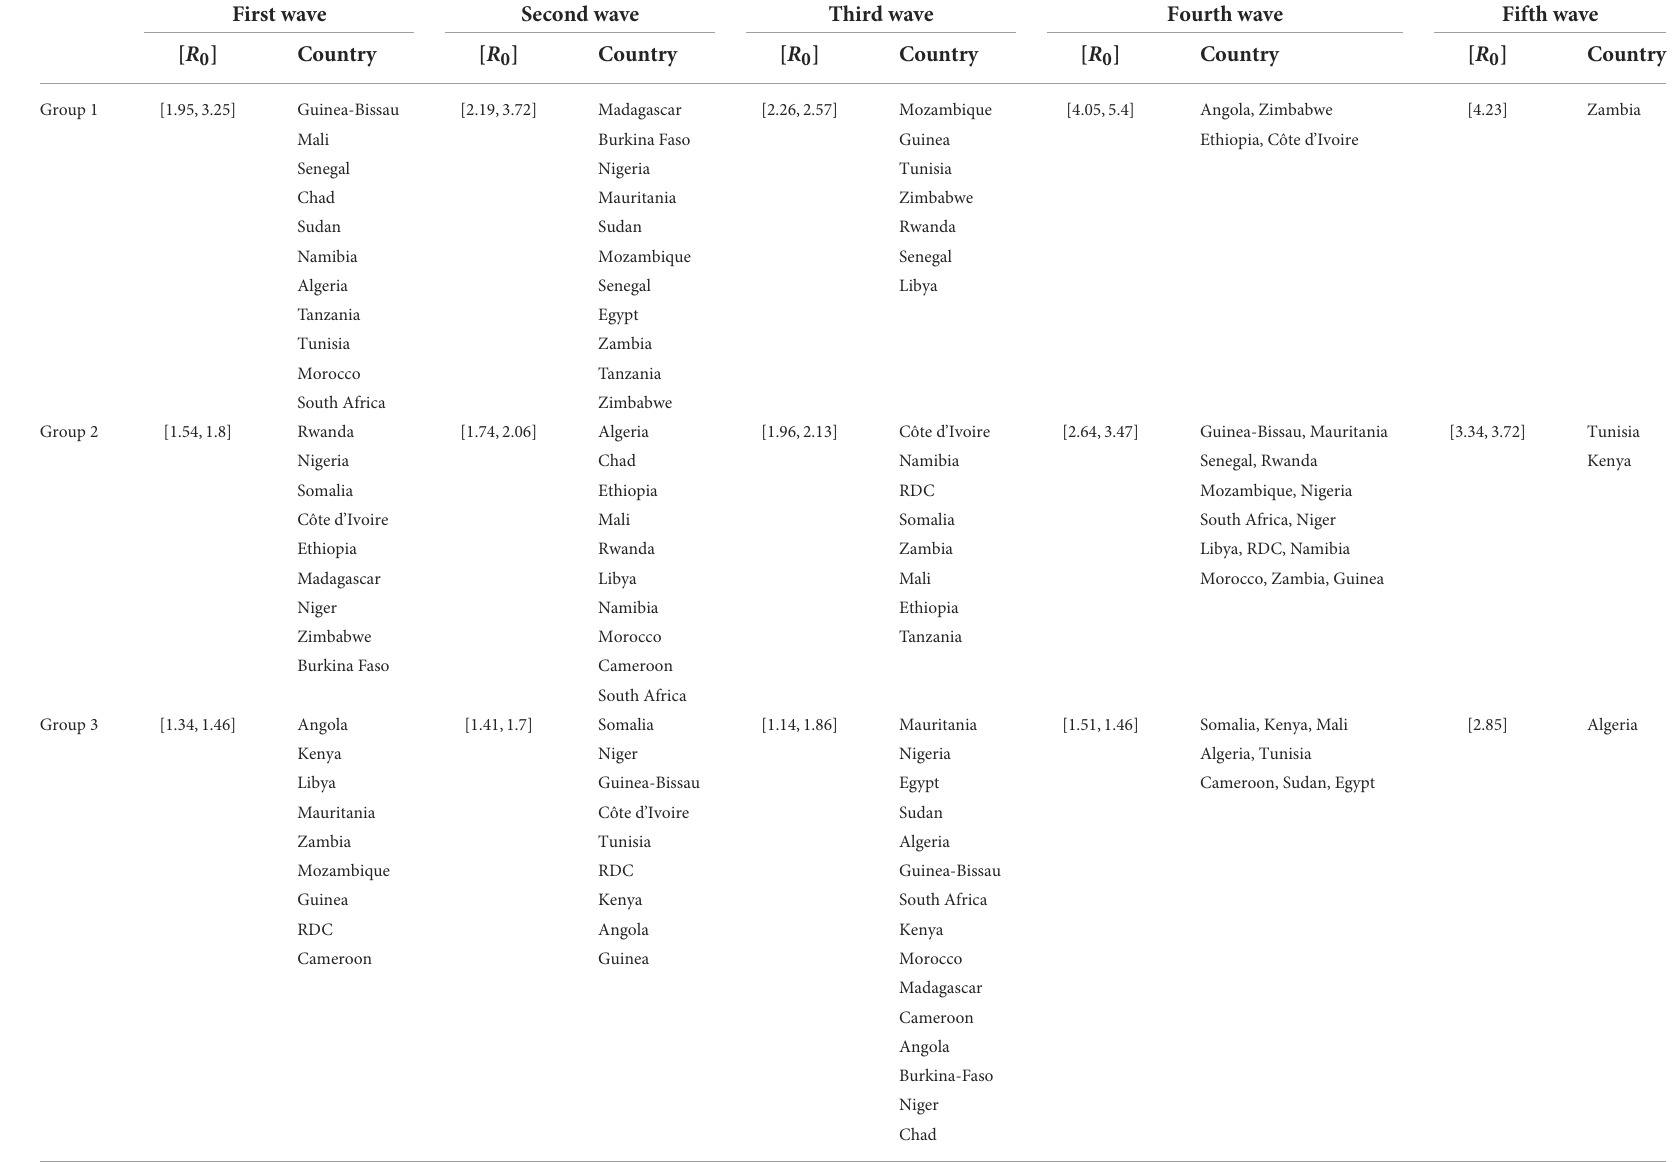
TABLE 3 Distribution of the country between a Group of R 0 for each